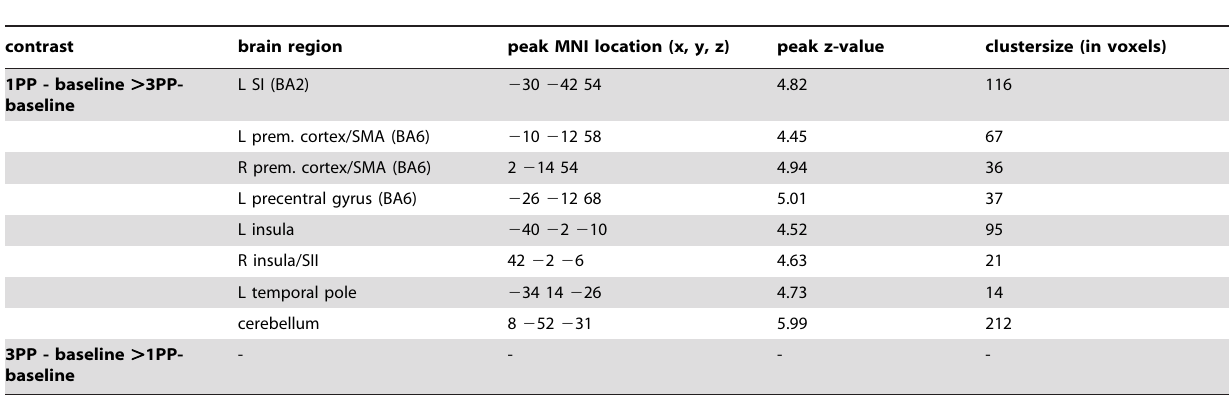
Table 2. Results of random effects analysis for 1PP (1PP-baseline) relative to 3PP (3PP baseline) (p , 0.05, FWE corrected, L= left hemisphere, R= right hemisphere, masked with real touch .